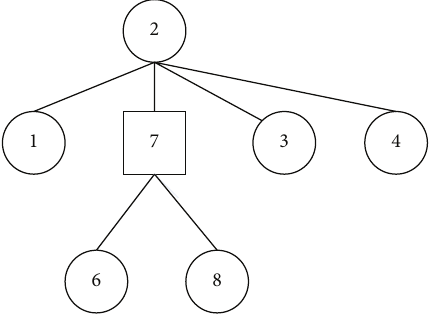
Figure 5: Illustration of localization smooth. Table 1: An example of weights and accumulative weights.